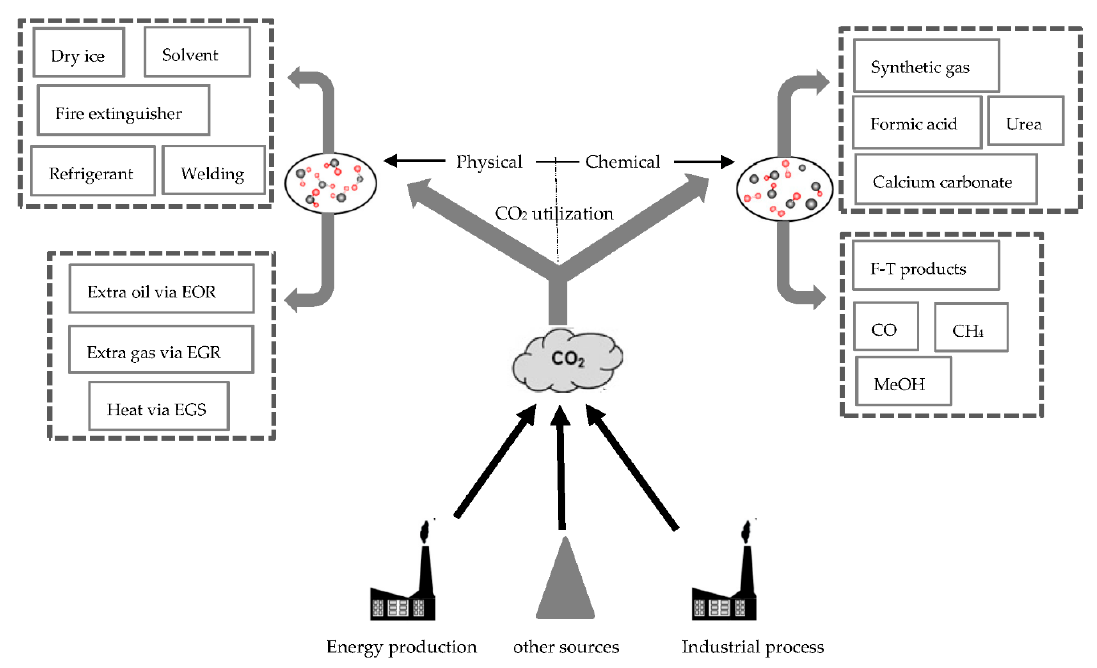
Figure 1. Various pathways for CO 2 utilization reprinted from [12] with permission from Elsevier.